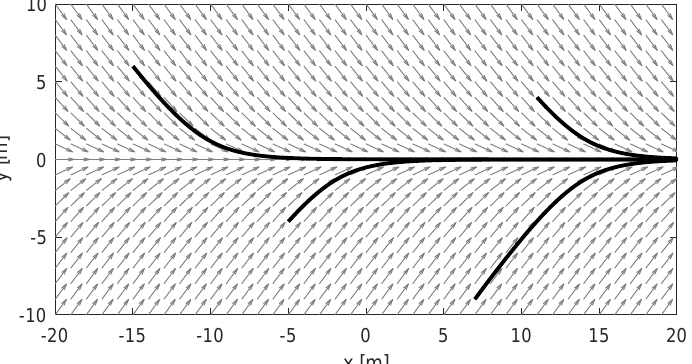
Figure 5. Example of a vector field that guides a robot to follow the x -axis. The gray arrows represent the velocity that would be given as input to the vehicle. The black curves are examples of paths that the vehicle would take by following the field.